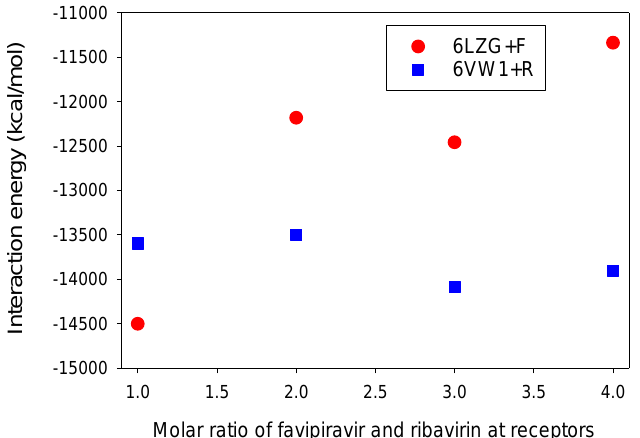
Figure 8. The interaction energies for different ratios of the structures of favipiravir and ribavirin with ACE2/SARS-CoV-2-CTD (6LZG) and RBD-ACE2 (6VW1). The 6LZG+F and 6VW1+R display 6LZG+favipiravir and 6VW1+ribavirin, respectively.